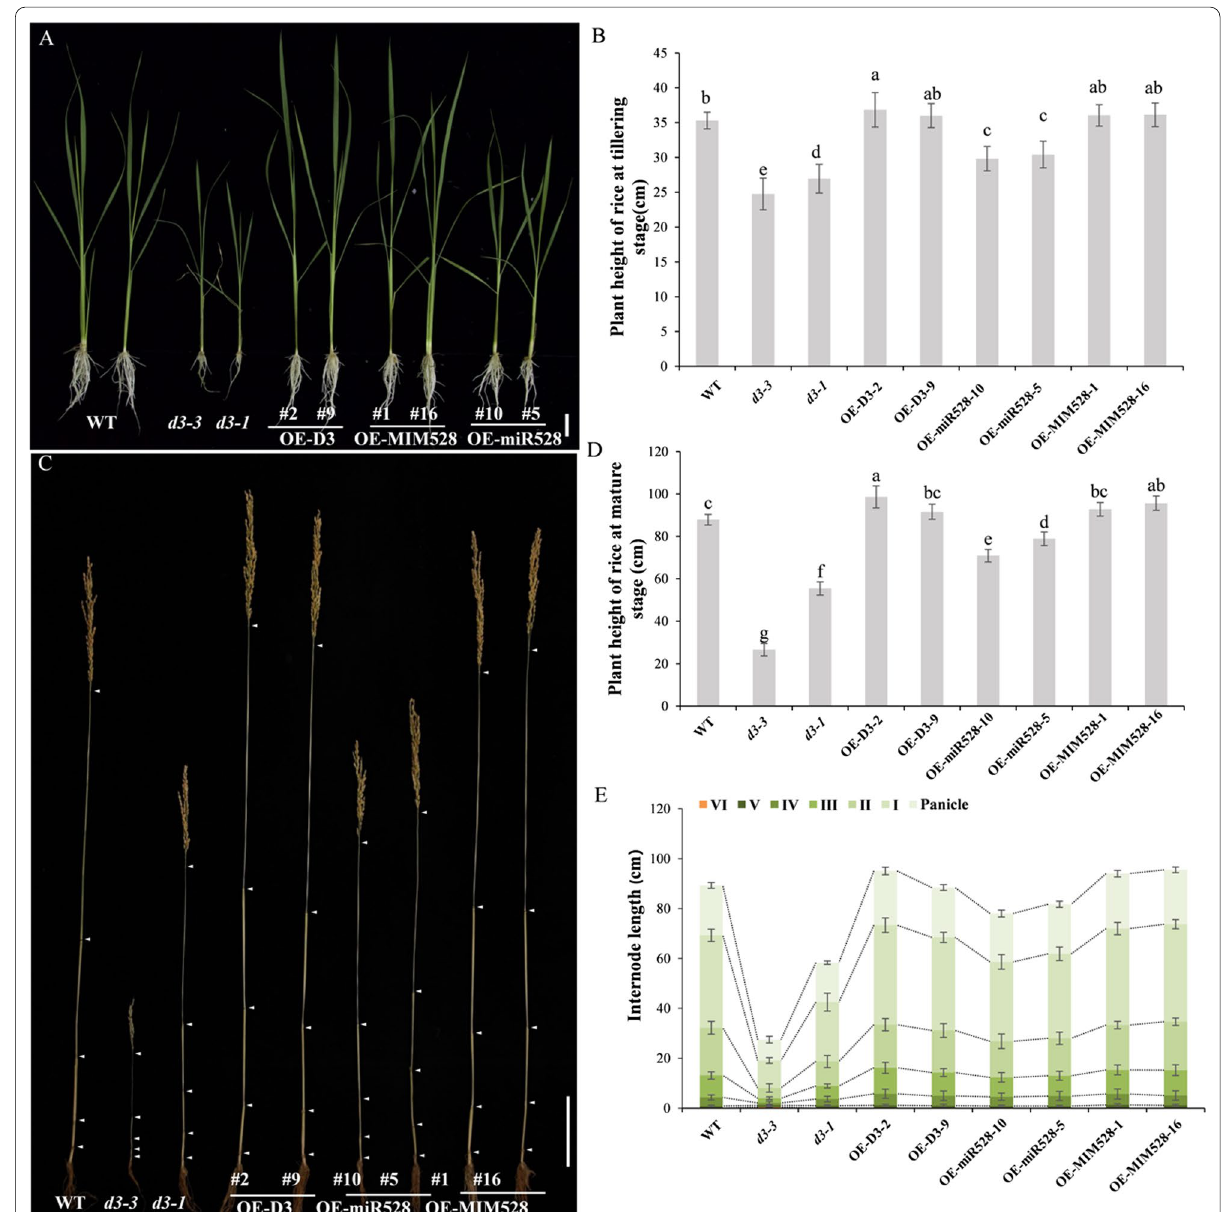
Fig. 2 Comparison of plant height and internode length between WT and transgenic lines at the tillering and maturity stages. A Phenotypes of WT and transgenic lines at tillering stage. Bars, 2 cm. B Comparison of plant height at tillering stage. Data are shown as the means Significant differences ( P < 0.05) are indicated by different letters. C Internode morphology of WT and transgenic lines. Bars, 10 cm. D Comparison of plant height at maturity stage. Data are shown as the means Comparison of internode length of WT and transgenic lines. Data are shown as the means